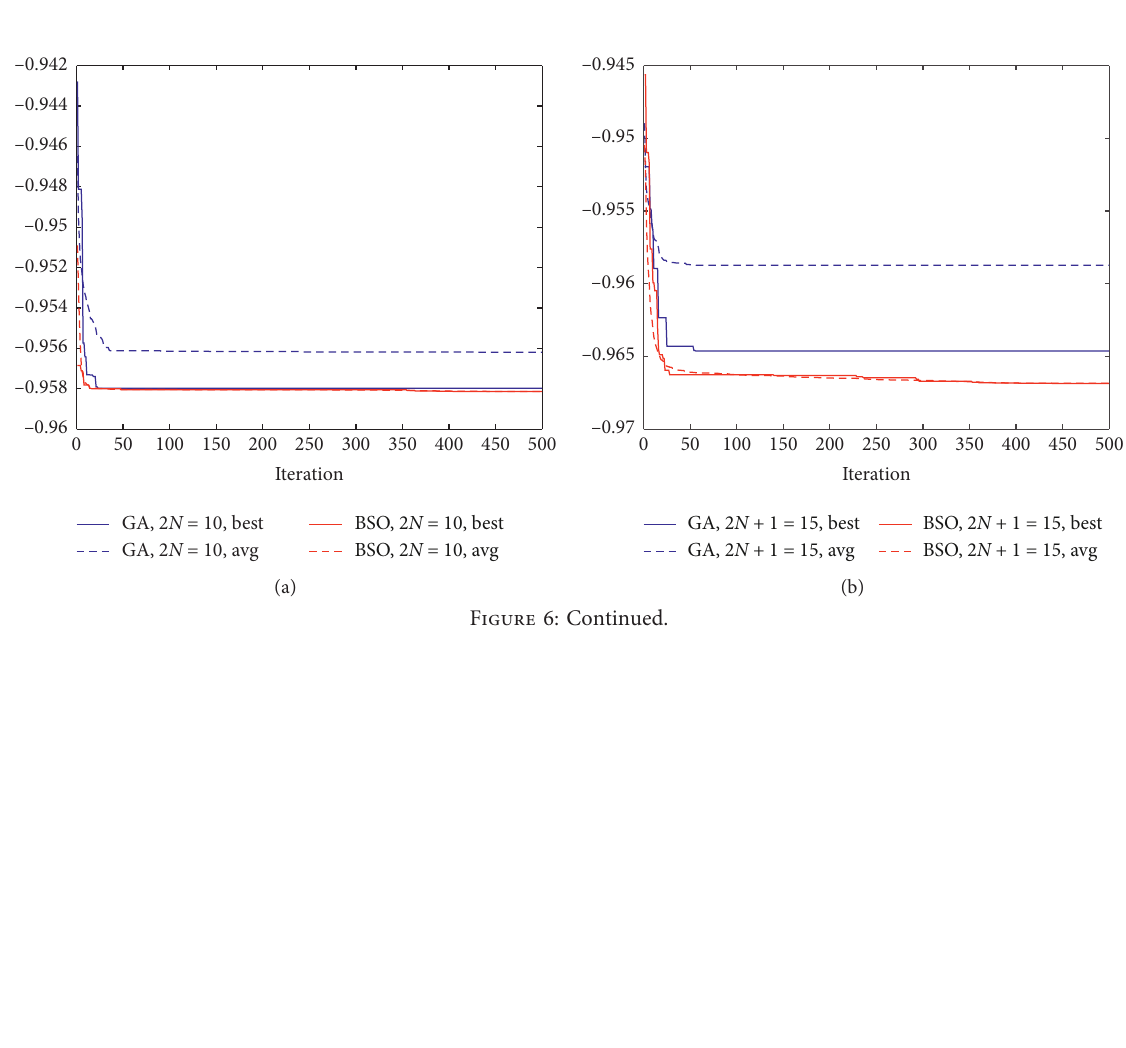
Figure 5: Different element examples: best-normalized power pattern found by BSO (a) and GA (b) (in 20 times runs).